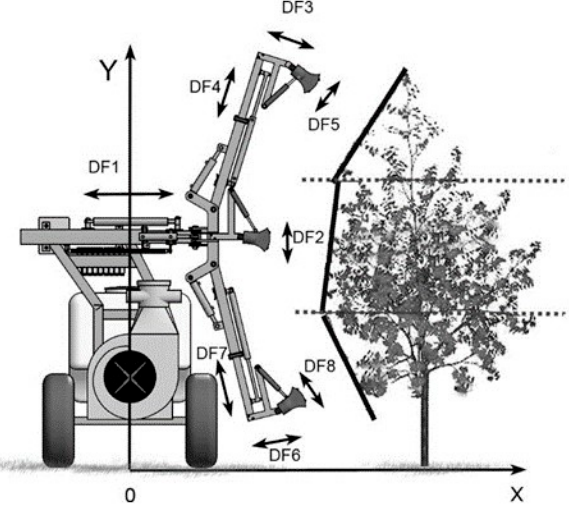
Figure 9. Variable nozzle position with eight degrees of freedom [93].